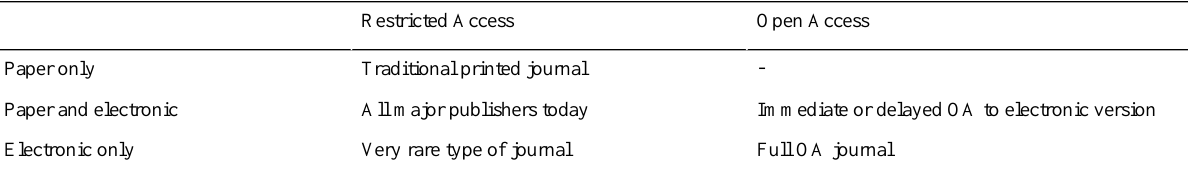
Table 1. A typology of scientific peer-reviewed